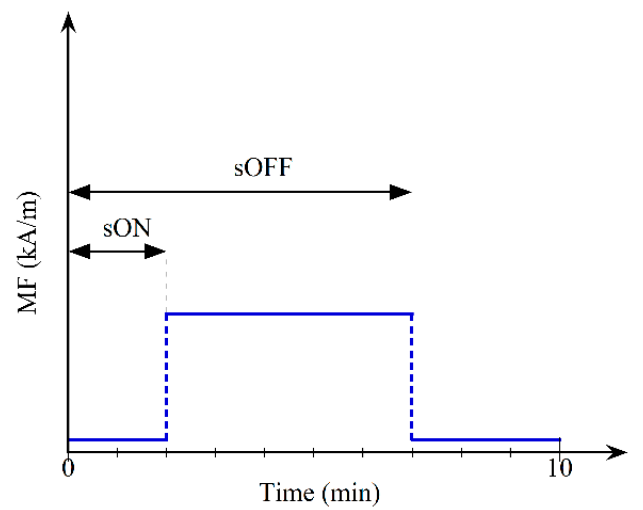
Figure 1. The magnetic field time profile (blue line) is schematized with switch-on (sON) and switch-off (sOFF) time